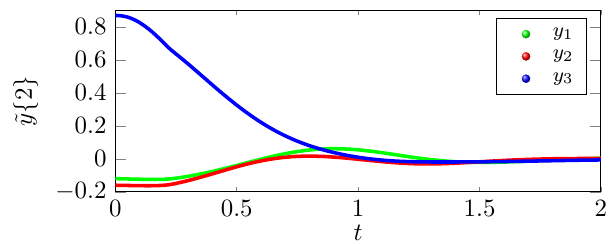
Figure 2. Tracking error with state feedback ˜ u ( 2 )